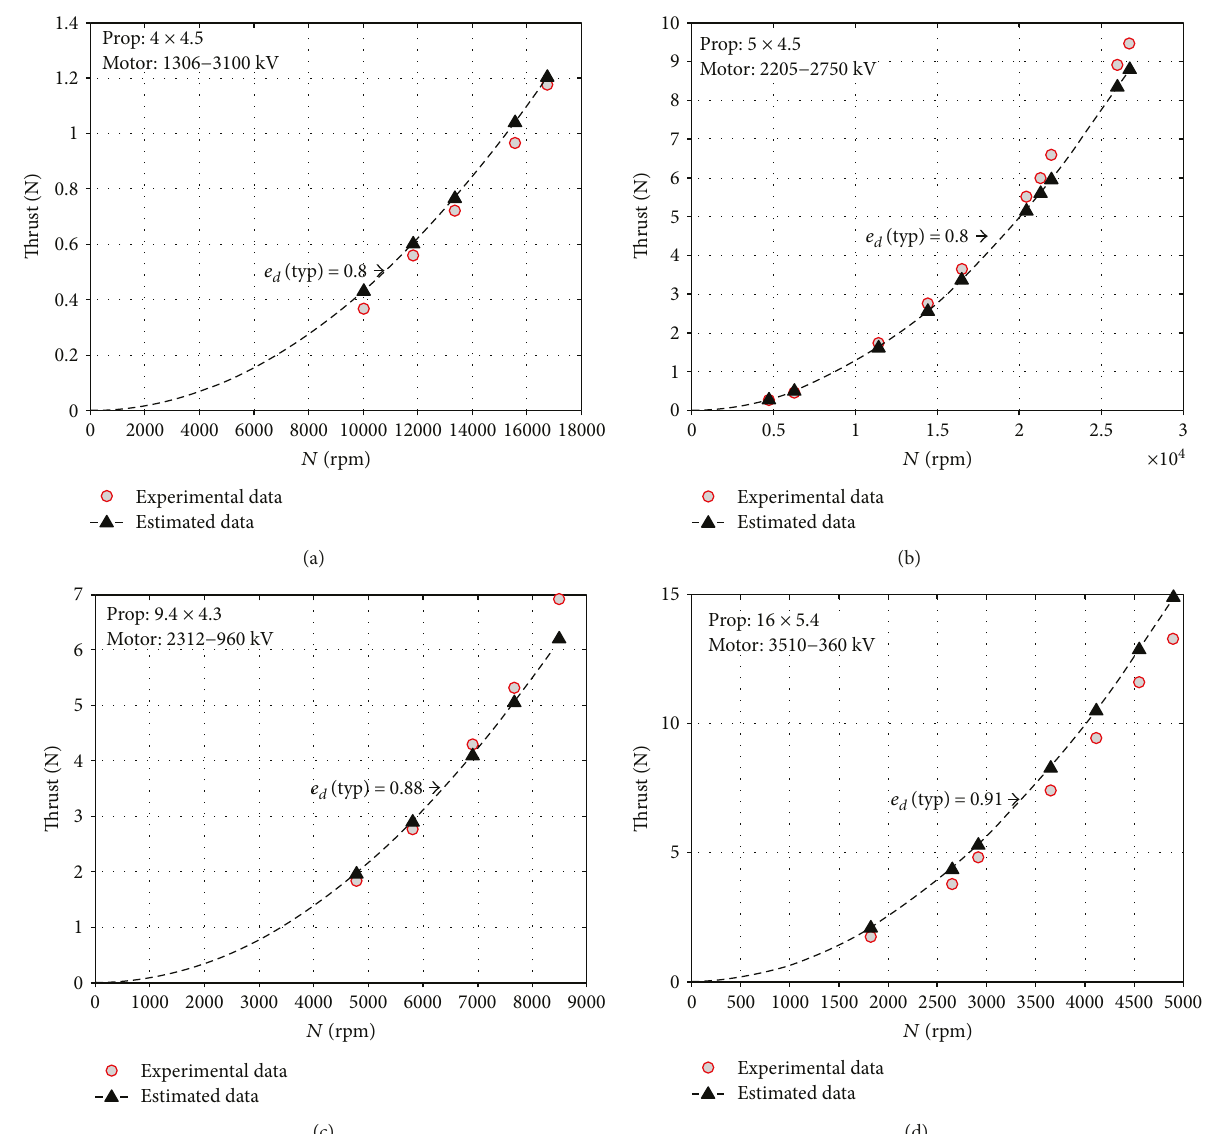
Figure 5: Veri fi cation for the proposed model using experimental